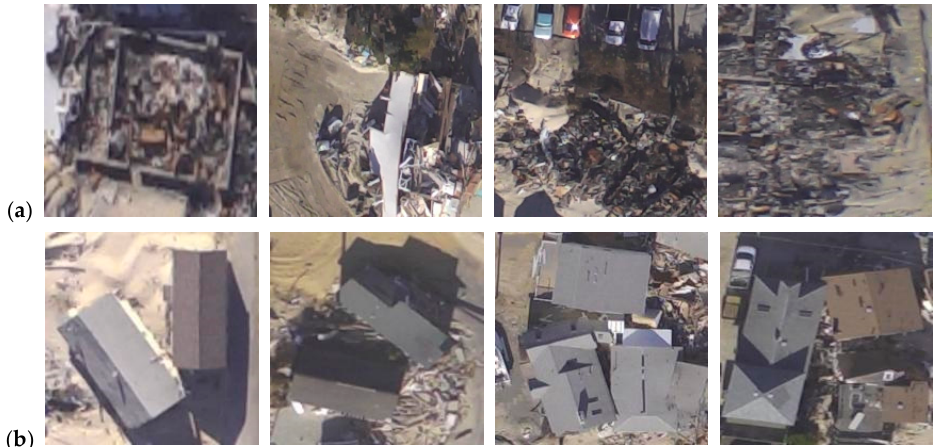
Figure 8. ( a ) The “debris” label represents ruins and destroyed buildings; ( b ) The “mild” label represents damaged buildings.